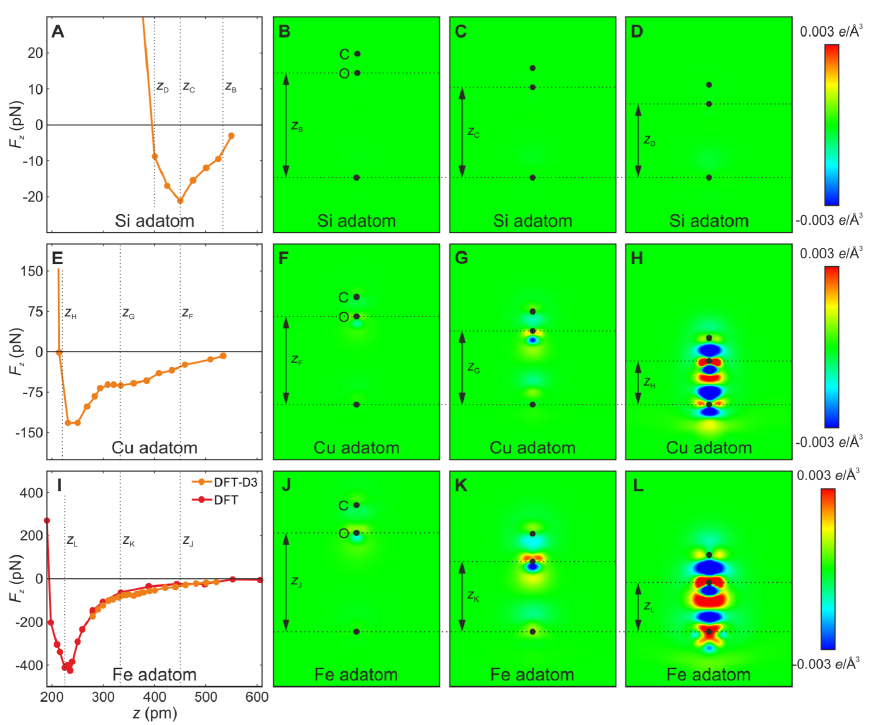
Figure 19. DFT and DFT-D3 calculations of vertical force versus tip-sample distance curves (left column) and of differential charge densities for a ( A – D ) Si adatom, ( E – H ) Cu adatom and ( I – L ) Fe adatom interacting with a CO-terminated tip for three different tip-sample distances as indicated in ( A ), ( E ) and ( I ), respectively. ( A ) For the Si adatom, only vdW attraction occurs with merely 30pN attraction before Pauli repulsion occurs. ( B – D ) The charge density plots show that no significant change in charge density occurs. ( E ) For the Cu adatom, we see, in contrast to the Si adatom, two local force minima: a shallow one due to physisorption and a deeper one with a maximal attraction of − 132pN due to chemisorption. ( F – H ) The differential charge density plots, in particular the one at the closest distance zH shown in ( H ), reveal significant charge redistribution due to hybridization, pointing to the formation of a chemical bond. ( I ) For the Fe adatom, we find a very shallow local vdW minimum caused by physisorption followed by a global force minimum of − 426pN due to chemisorption. ( J – L ) The differential charge density plots already show significant hybridization at a distance z K and more so at z L , pointing to the formation of an even stronger chemical bond compared to the case of the Cu adatom. Adapted with permission by American Association for the Advancement of Science from Figure S7 in